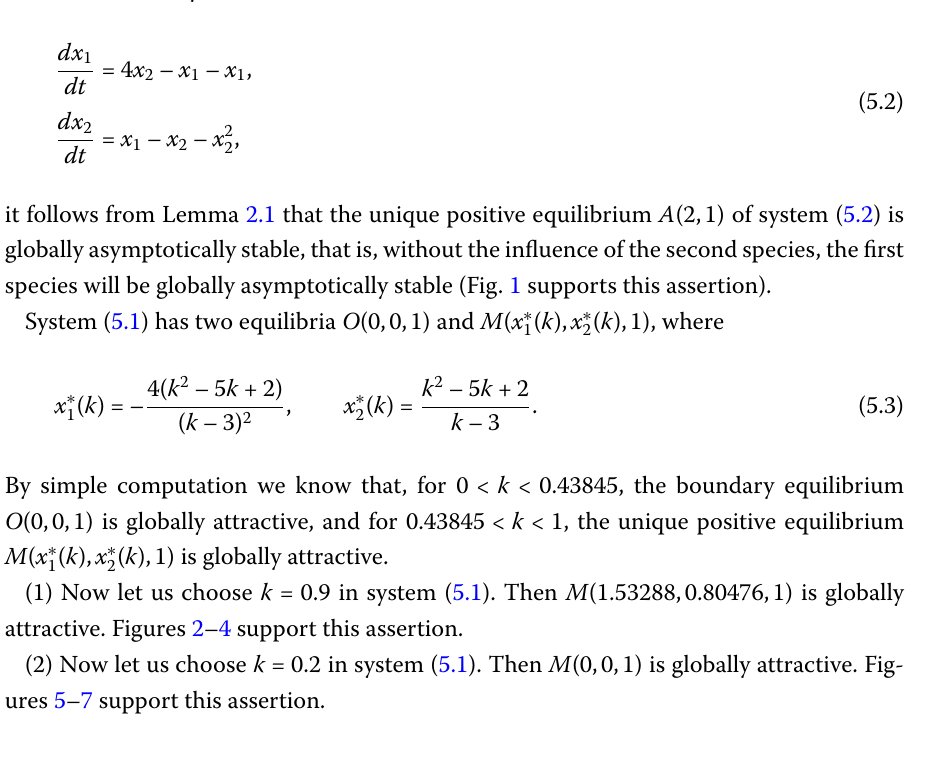
Here we choose α = 4, β = δ 1 = δ 2 = γ = a 2 = b 2 = d 1 = d 2 = 1. Hence β + δ αβ = 4 > 2 = δ 2 ( 1